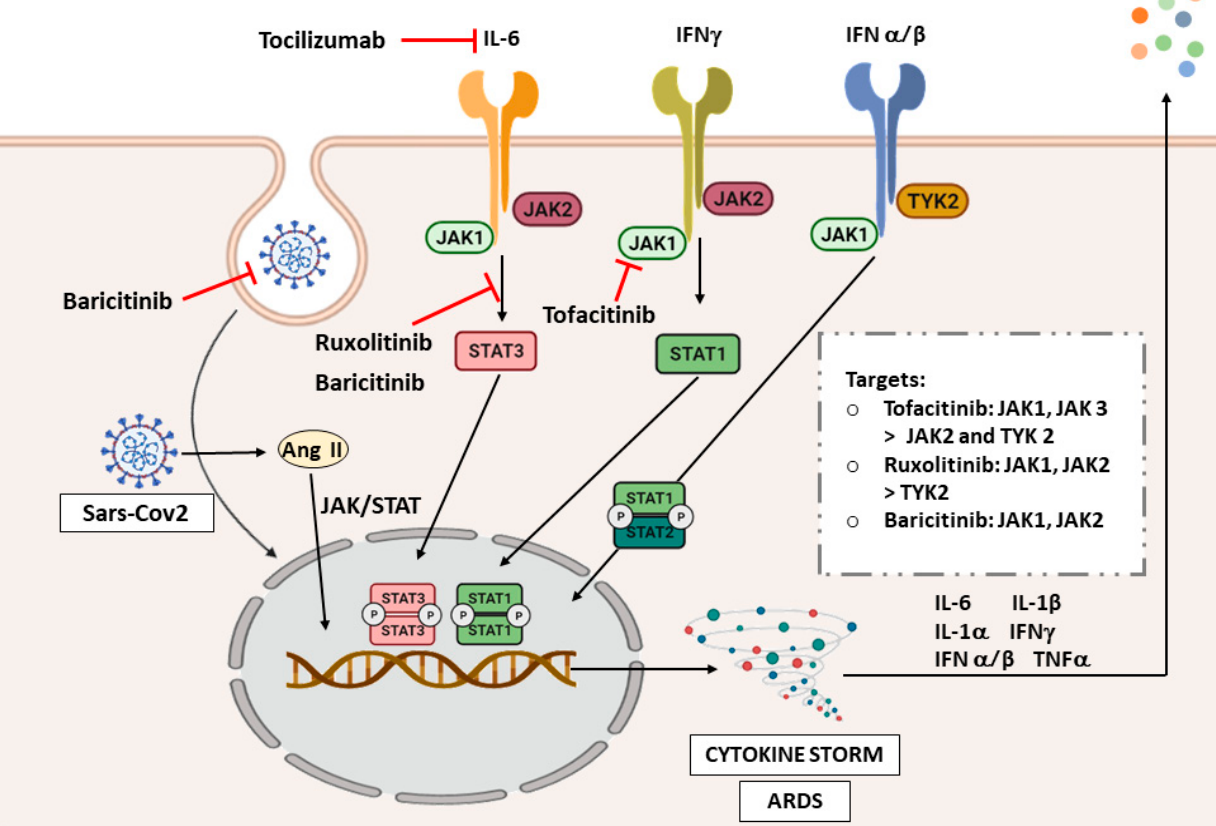
Figure 3. JAK/STAT inhibitors in COVID-19. Abbreviations: interferon (IFN), angiotensin II (Ang II), acute respiratory distress syndrome (ARDS). The image was created with BioRender.